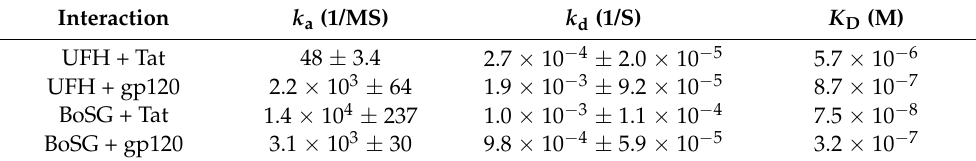
Figure 5. SPR sensorgrams of unfractionated heparin UFH; ( A , B ) and Botryocladia occidentalis sulfated galactan BoSG; ( C , D ) in interactions with HIV-1 Tat ( A , C ) and gp120 ( B , D ). Concentrations of HIV-1 proteins are shown color-coded in the panels. The black curves are the fitting curves using models from BIAevaluate 4.0.1. Table 1. Kinetic values from the molecular interactions between UFH and BoSG with Tat and gp120.